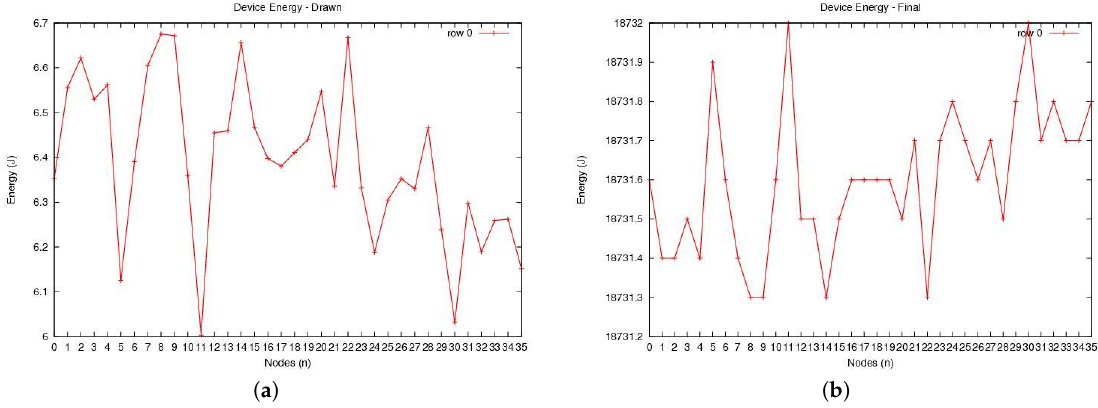
Figure 7. Energy profile: ( a ) the amount of energy drawn and ( b ) the remaining amount of